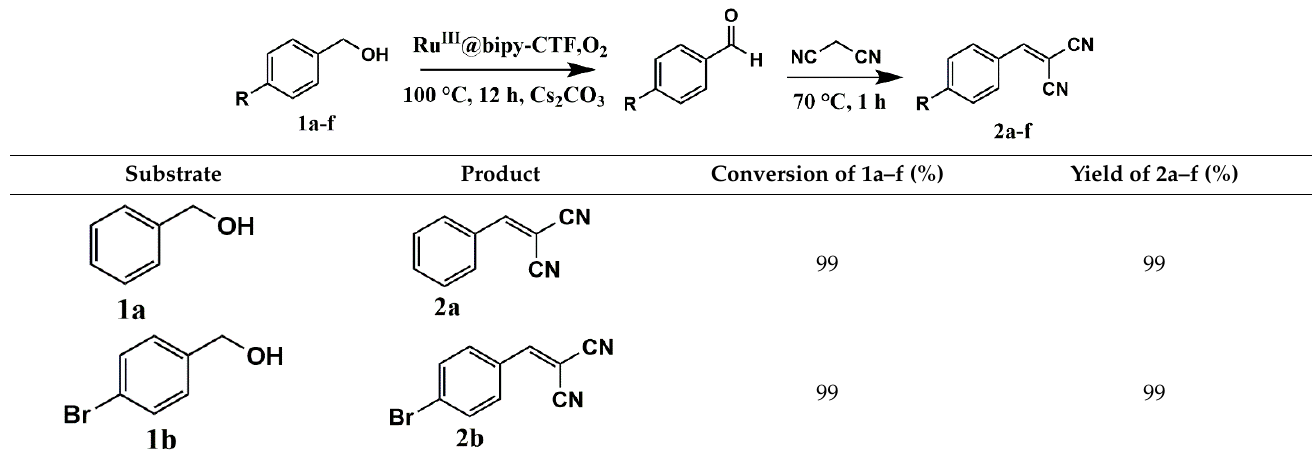
Molecules 2021 , 26 , x FOR PEER REVIEW